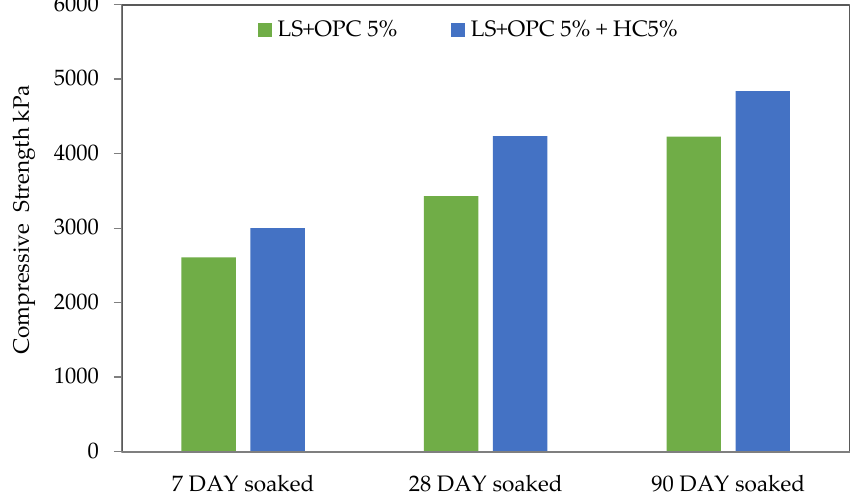
Figure 3. Compressive strength for curing in air (7, 28, and 90 days soaked).